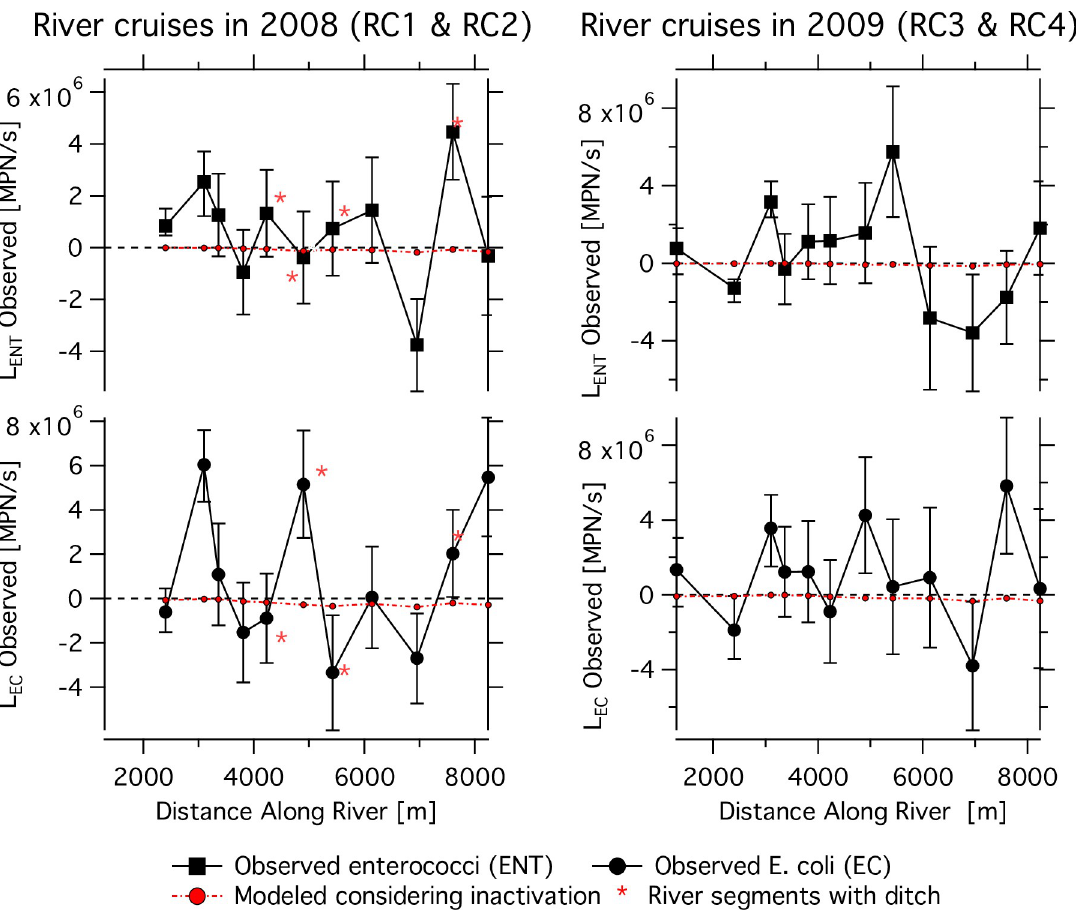
Fig 5. Observed and model loading results. Hanalei river loadings in 2008 (left panel) and 2009 (right panel). ENT loadings (squares) are shown in the top panels and EC loadings (circles) are shown in bottom panels. Red lines show model predictions for changes in loading due to inactivation. Red asterisks indicate river segments where a ditch drains into the river. The asterisks are only shown on the left panels. The distance represents the location of the downstream end of the river